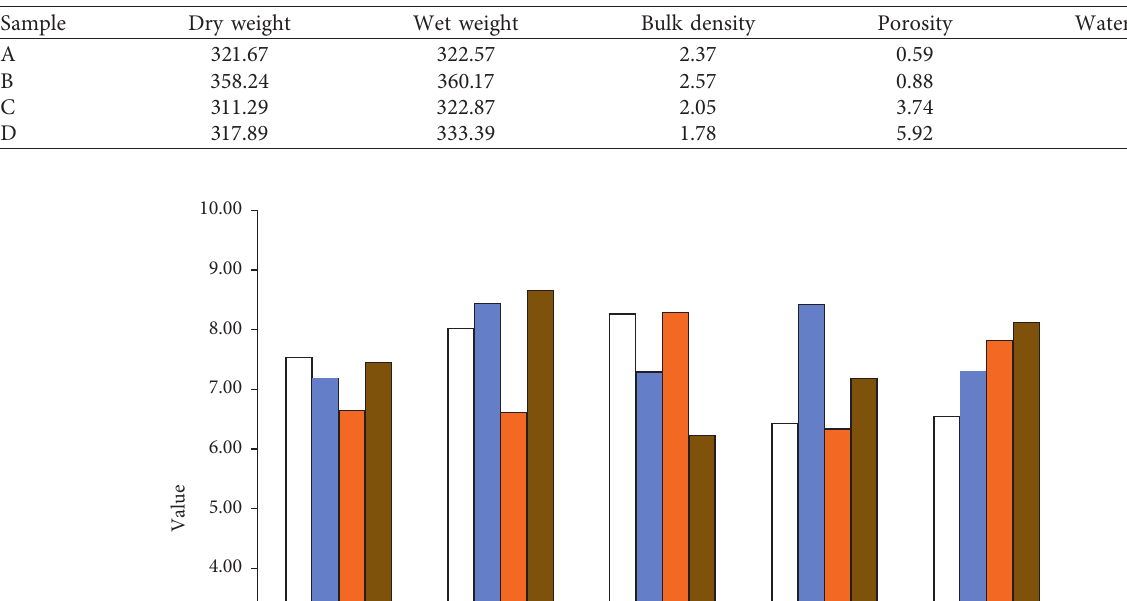
Table 4: Four formulations of alumina ceramic samples for testing.